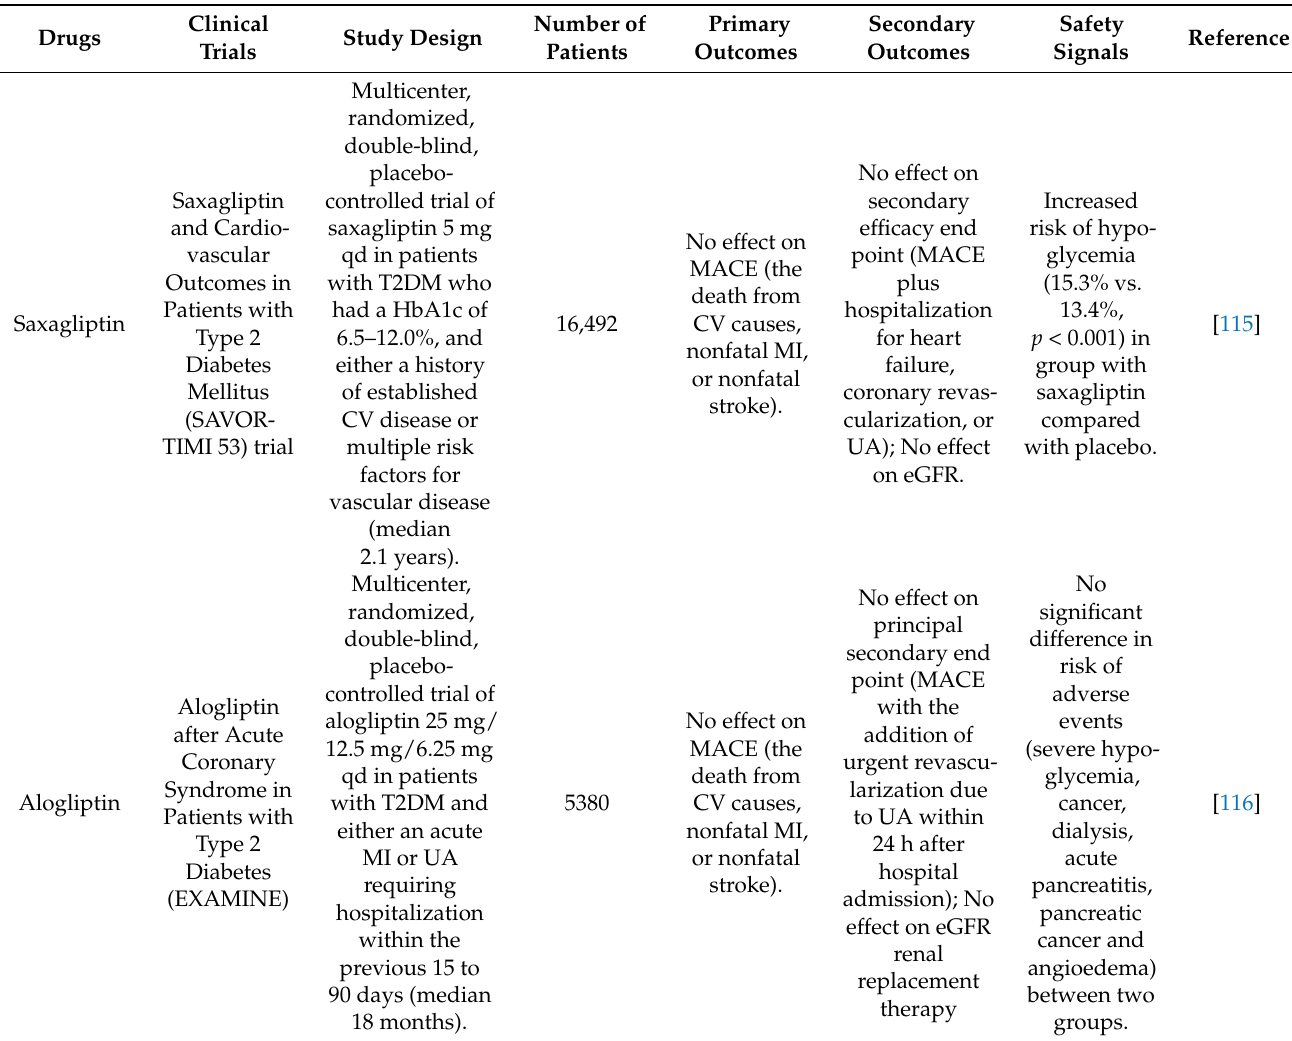
Table 4. Major clinical studies related to DPP-4